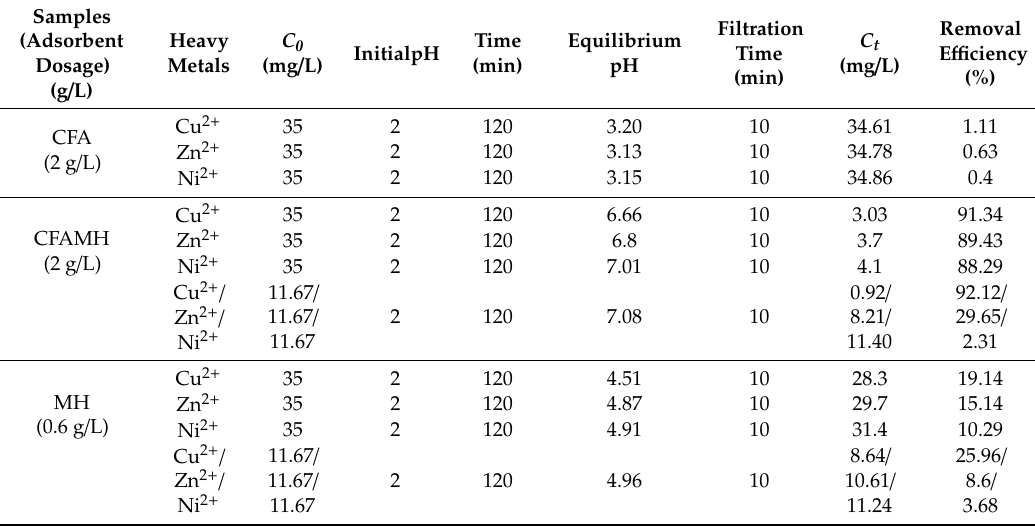
Table 3. The adsorption results of calcined fly ash (CFA), calcined fly ash coated with magnesium hydroxide (CFAMH) and magnesium hydroxide (MH) for removal of heavy